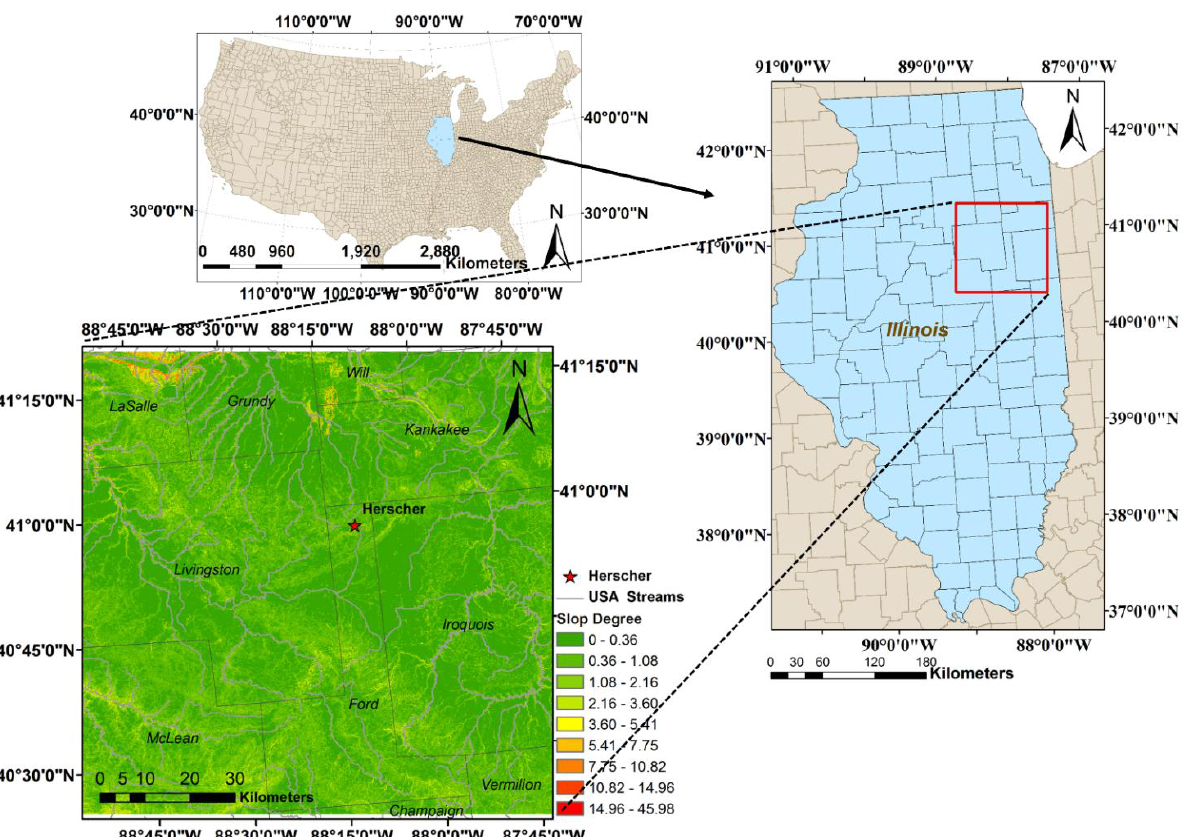
Figure 2. Location of study area with a slope map